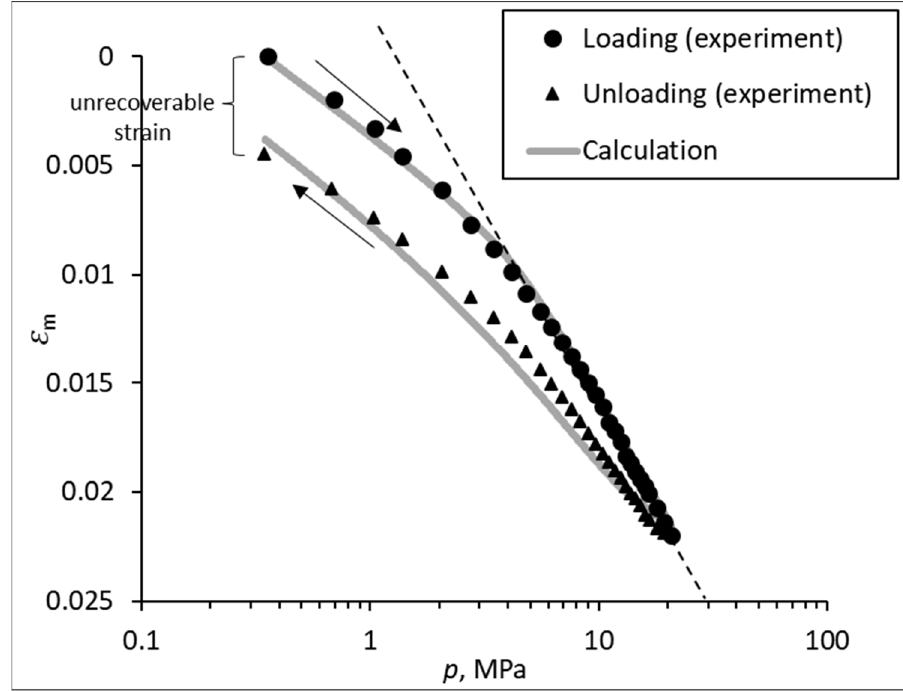
Figure 5. Strain–stress path and permeability of coal sample 1 in a stress cycle.